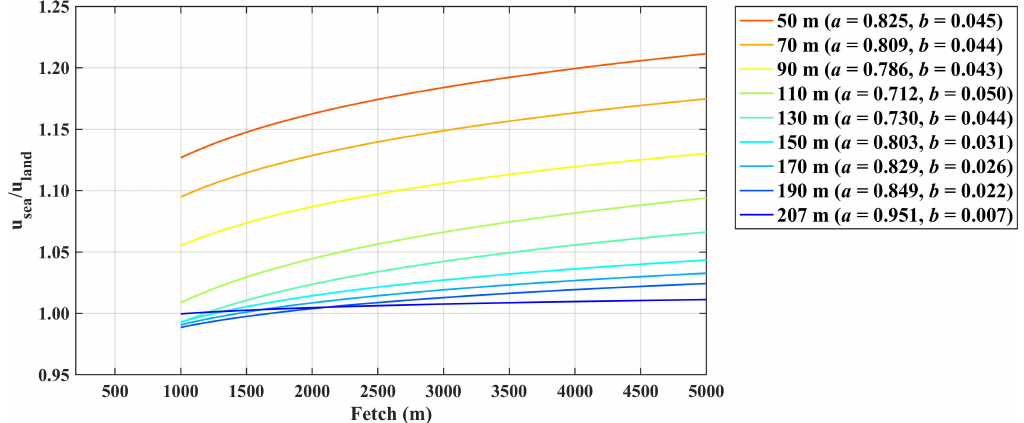
Figure 15. Empirical equations of the ratio of onshore and offshore wind speeds as functions of the fetch length and height, derived from the LiDAR observations for more than a 1000 m fetch length.